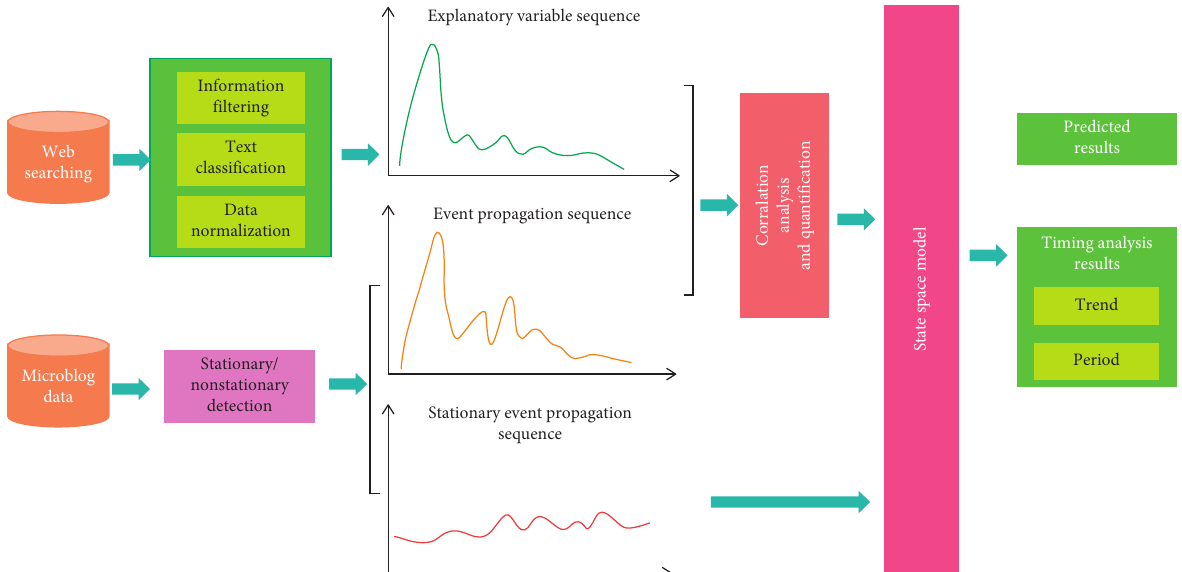
Figure 3: A popularity prediction framework for information propagation of a hot event on the Weibo social network. First, the explanatory (time) variables of an event were determined by the data preprocessing, and the key variables affecting the event propagation were identified by the correlation analysis. Second, the framework recognizes the propagation type (stationary or nonstationary) of the event. Third, a DLM is established based on the variables and the event propagation type. Consequently, time-series analysis can be conveniently achieved based on the